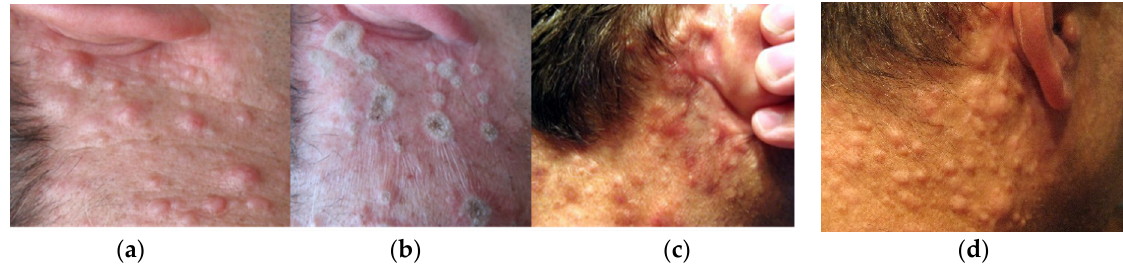
Figure 8. Laser therapy of dermal neurofibroma at right side of the neck below ear region using DL radiation with wavelengths 975 nm and continues wave, power: 12 W; ( a ) view before irradiation, ( b ) soon after irradiation (55 s), ( c ) 7 weeks after laser treatment, ( d ) one year after therapy.